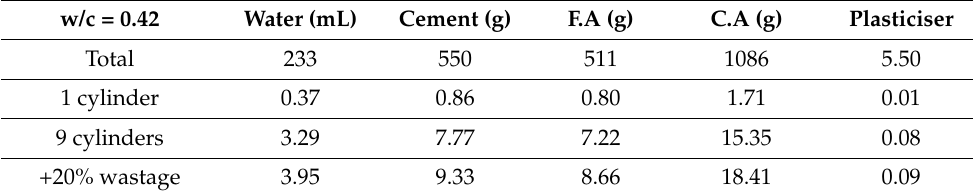
Table 3. Optimal design mix.